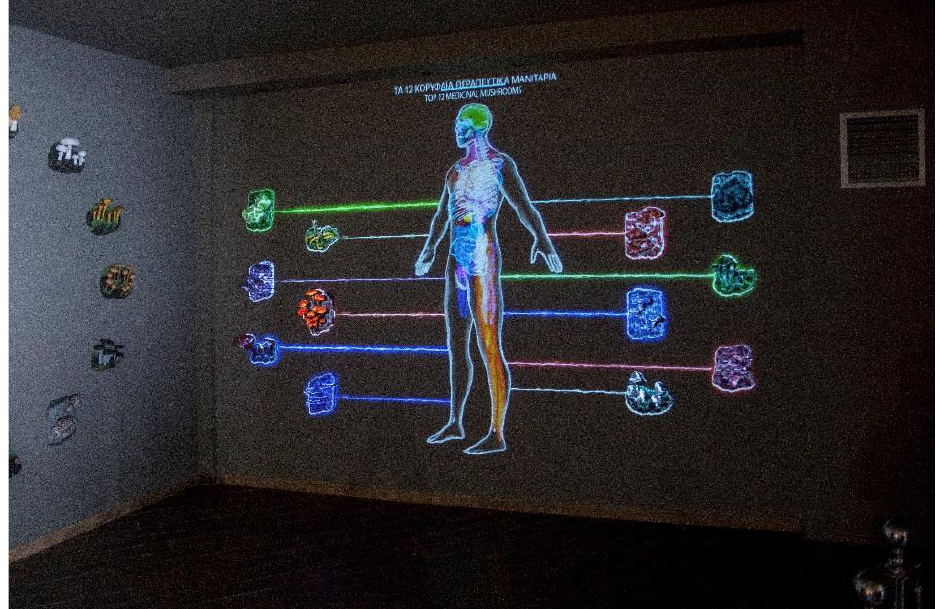
Figure 1. Τ he benefits of mushrooms in specific organs. Figure 1. The benefits of mushrooms in specific